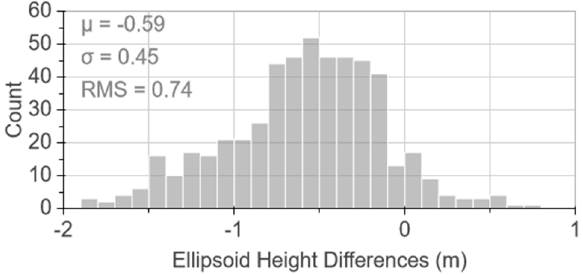
Figure 13. The distribution of differences between the ellipsoid heights of the detected bottom photons and the nearest reference depth has a root mean square (RMS) error of 0.74 m.